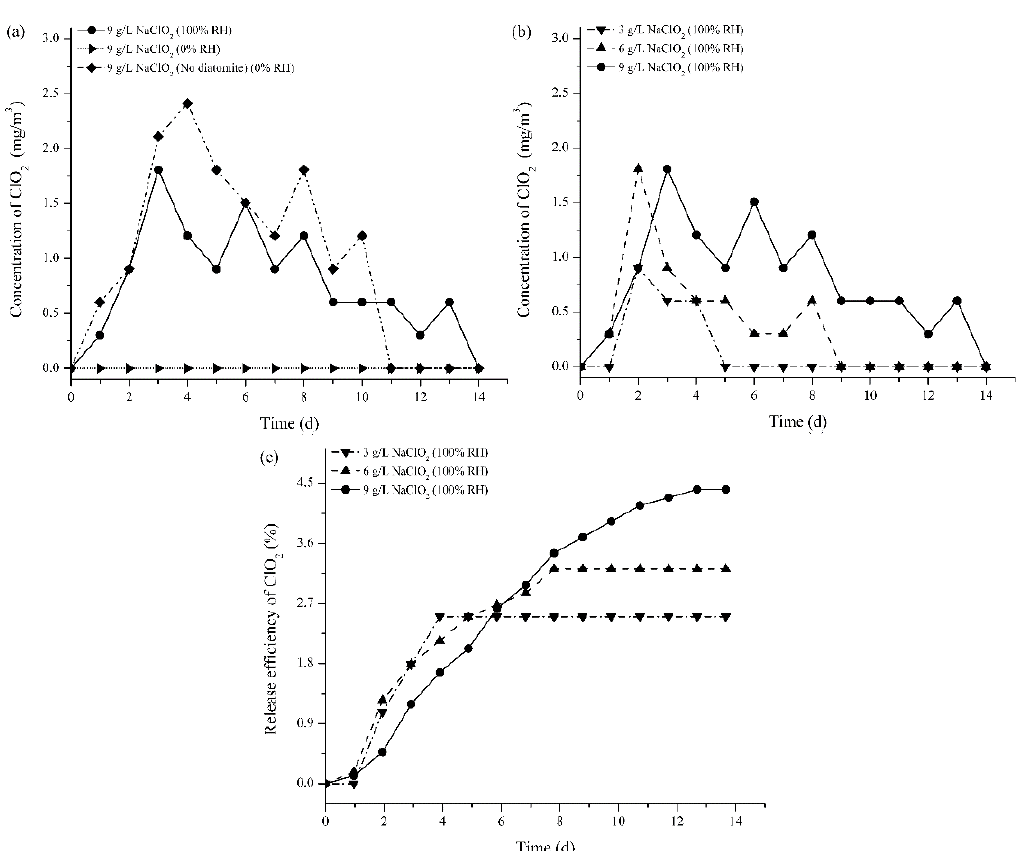
Figure 2. Schematic diagram of the release process of ClO 2 from the coated corrugated cardboard. 3.2. Effects of the Coated Corrugated Box on Strawberry Preservation 3.2.1. Decay Rate The decay rate of strawberry increased rapidly when stored at room temperature. As shown in Figure 3a, strawberries packed in control box started to decay on day 2, which showed a decay rate higher than 80% on day 5. However, the decay rate of strawberries packed in 6 g/L NaClO 2 and 9 g/L NaClO 2 boxes was two times lower compared to that packed in control on day 3. The appearance of strawberries shown in Figure 3b clearly revealed the mold growth was greatly inhibited when they were packed in 6 g/L NaClO 2 and 9 g/L NaClO 2 boxes, which indicated the successful release of ClO 2 in these boxes. In the boxes, water vapor and CO 2 were able to be constantly produced by the active transpiration and respiration process of strawberries, which would be absorbed by the chitosan and PVA coatings on the cardboard and result in swelling of polymers chains and penetration of H + to react with ClO 2 ˉ . As a result, gaseous ClO 2 was constantly produced and released from the coating